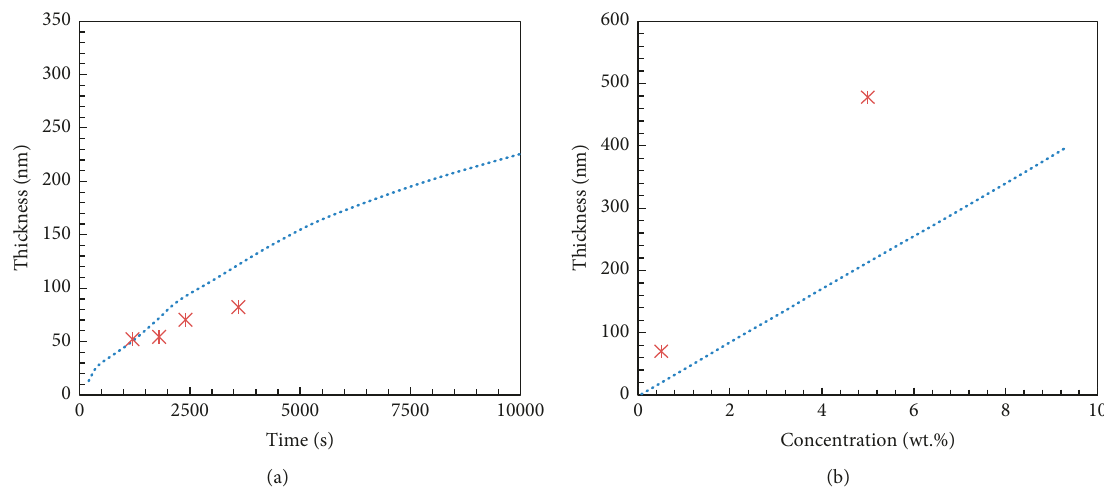
Figure 8: Thickness silica nanocoating versus (a) deposition time (dash line is the trend line in Charlot et al. experiment [20]) and (b) concentration (dash line is the Hamaker model [19]).